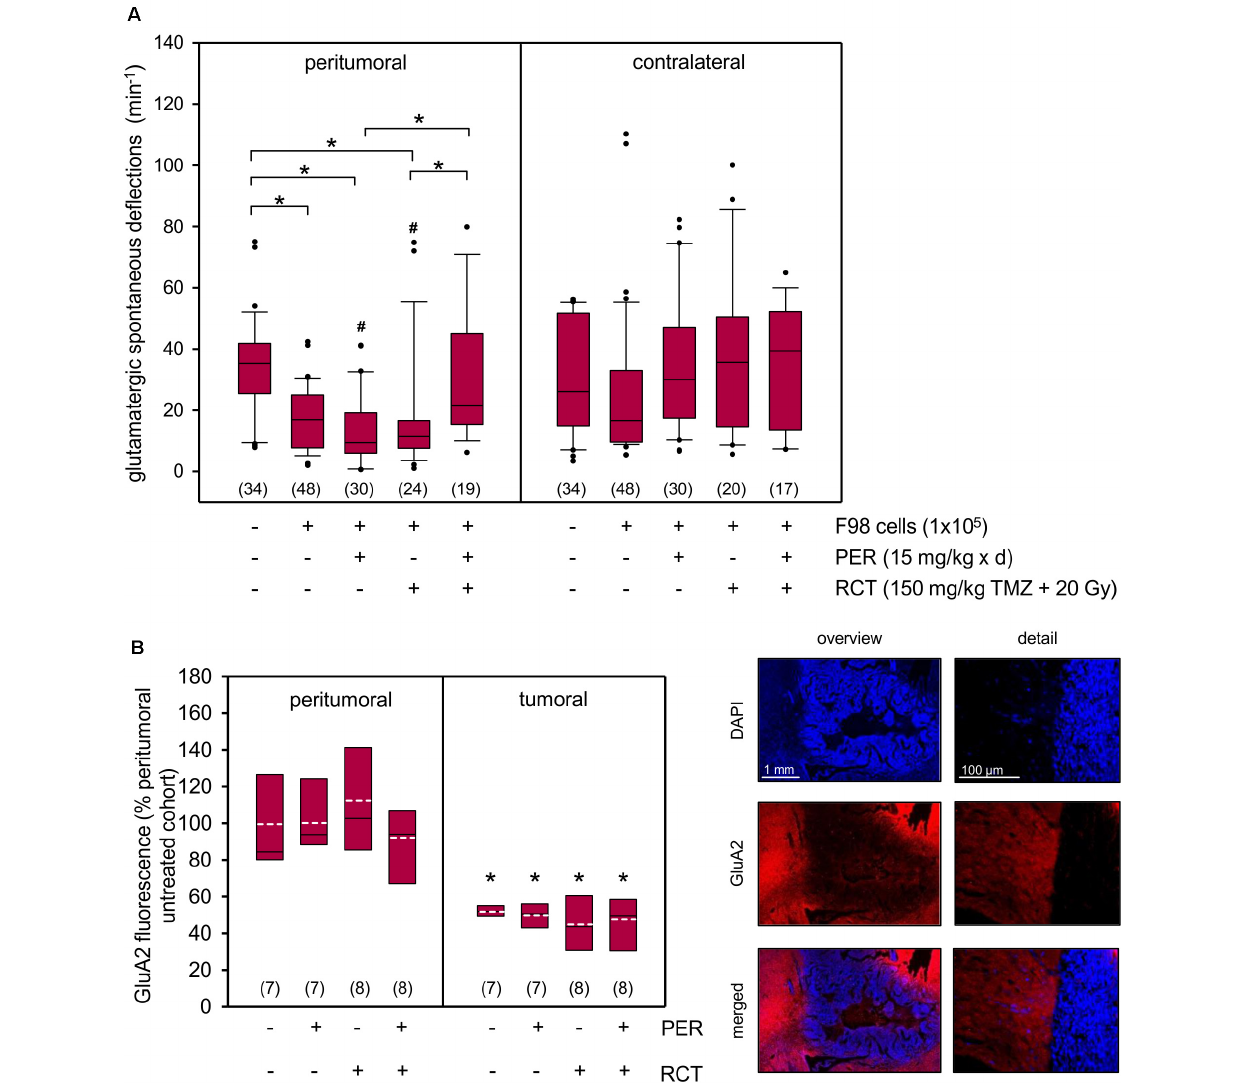
FIGURE 5 | Synergistic impact of PER and RCT on glutamatergic network activity and GluA2 expression in acute F98 glioma slices. (A) One week after stereotactic injection of 1 × 10 5 F98 cells, RCT with fractionated irradiation (5 × 4 Gy), concurrent administration of temozolomide (5 × 30 mg/kg bw) and an anticonvulsive treatment with PER (15 mg/kg bw/day) was started. After a total of 14–15 days animals were sacrificed and brain slices were prepared for electrophysiological analysis. The slices were exposed to aCSF 0 mM Mg 2 + and 5 µ M gabazine and field potential recordings were performed in surrounding tissue; n = 17–48 number of measurements (brain slices were from a total of 35 rats); * p < 0.05 (Kruskal–Wallis test followed by post hoc analysis (Dunn’s test); # < 0.05 versus contralateral equivalent ( U test). (B) AMPA receptor subunit GluA2 expression was determined in the tumor area and peritumoral tissue of the ipsilateral hemisphere. Glu2A (red) immunofluorescence was normalized to peritumoral immunofluorescence intensity of the vehicle controls without PER or RCT (see section “Materials and Methods”). Nuclei were counterstained with DAPI (blue); white dotted line represents arithmetic mean, black solid line represents median. Significant difference between peritumoral and glioma fluorescence for each group was determined ( n = 7–8 animals per group; * p < 0.05; U test).